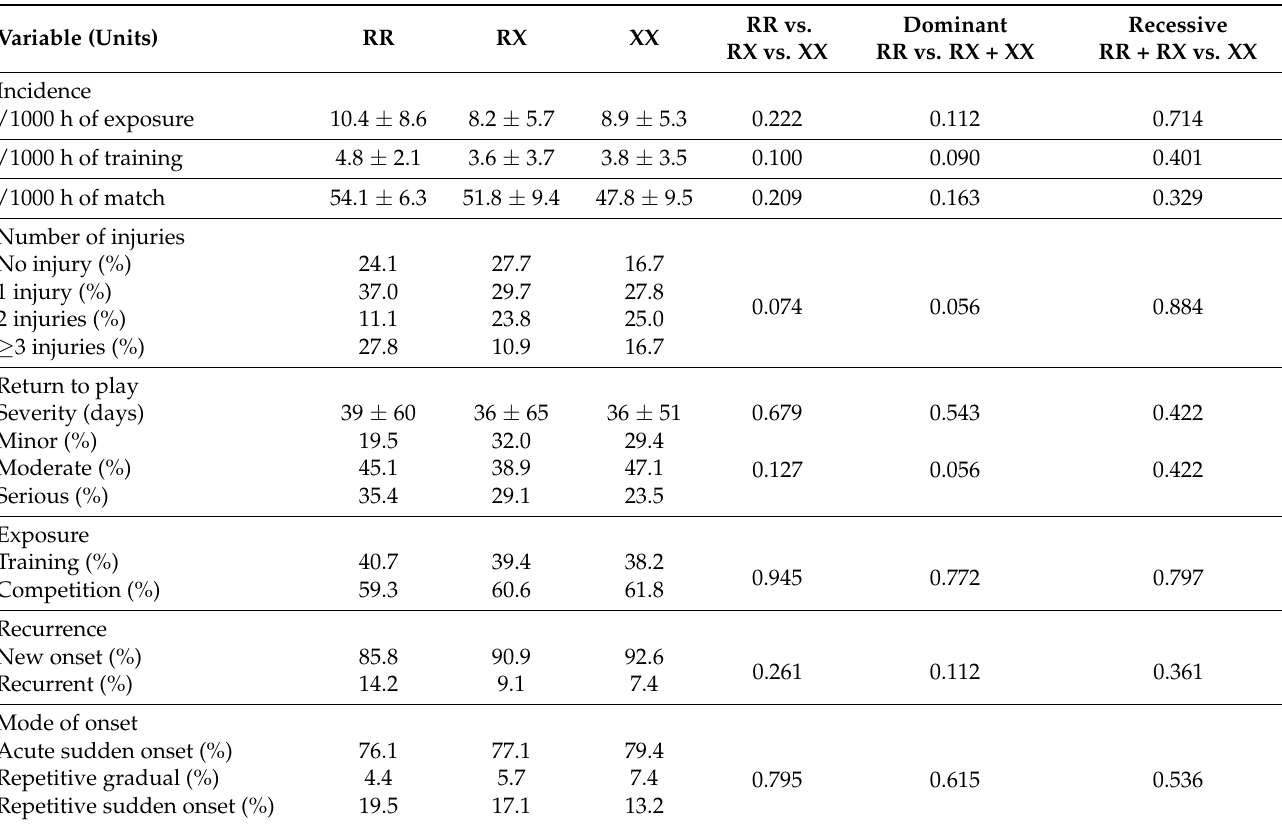
Table 4. Injury incidence, distribution of players according to the number of injuries, and distribution of injuries according to severity, exposure, recurrence and mode of onset in women football players of the first division of Spanish football with different ACTN3 R577X genotypes.